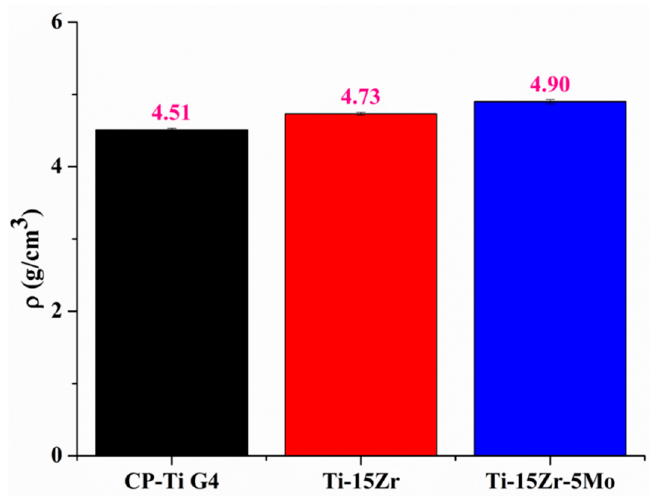
Figure 1. Comparison of density values.